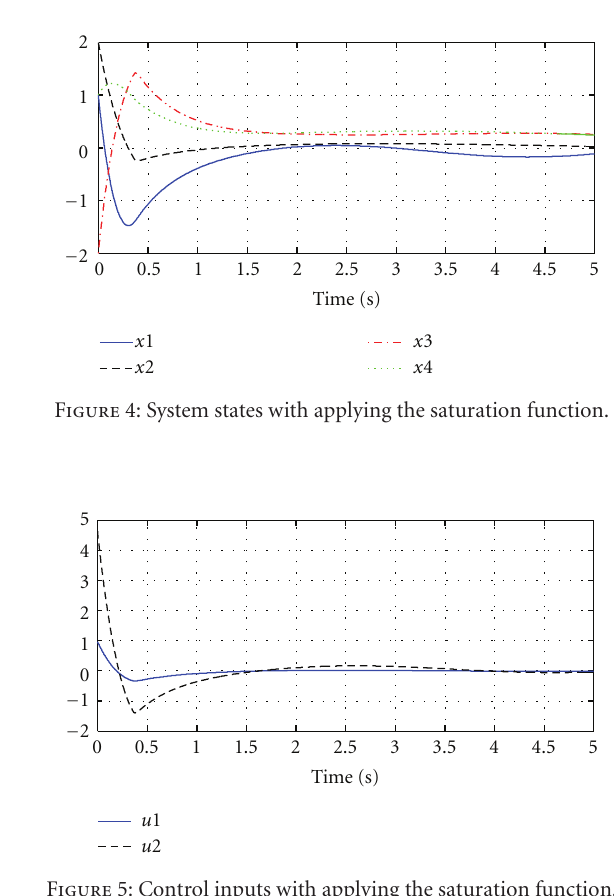
Figure 5: Control inputs with applying the saturation